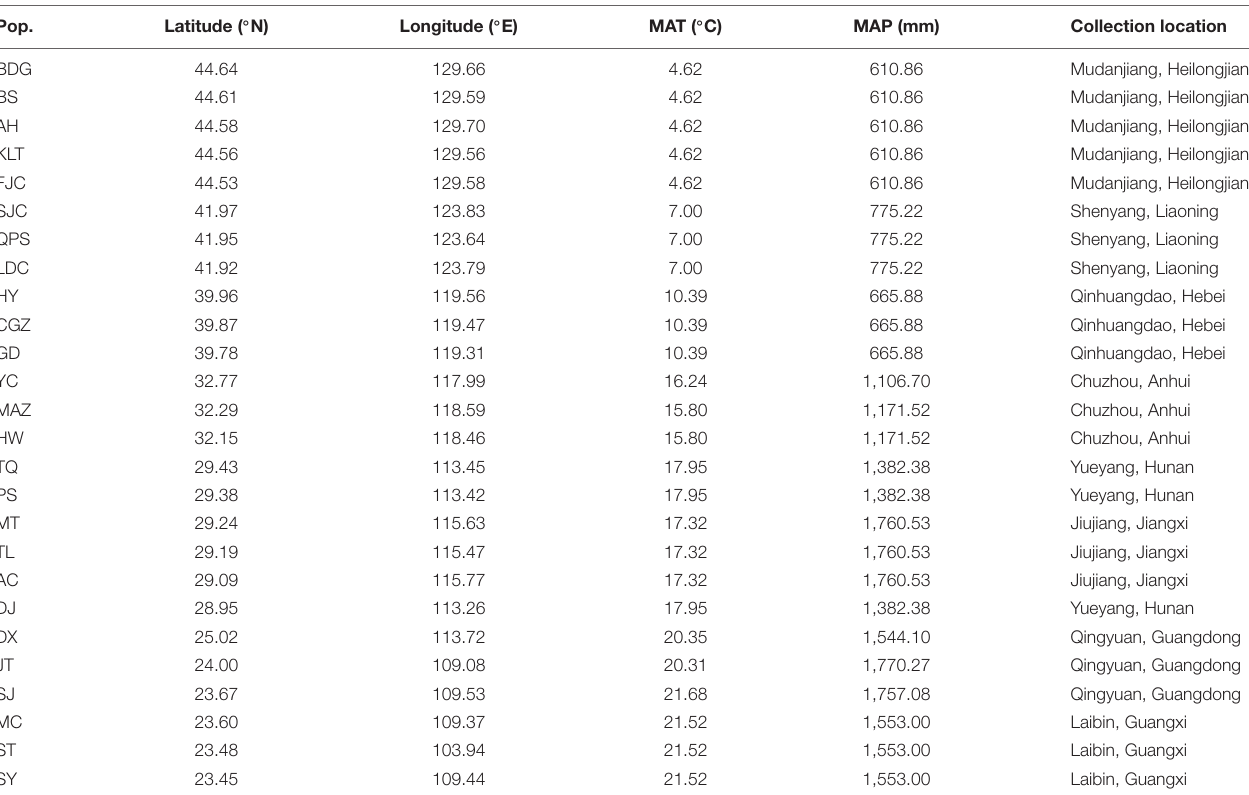
TABLE 1 | Geographic locations and home climate (mean annual temperature, MAT; mean annual precipitation, MAP) of 26 populations of Ambrosia artemisiifolia used in this study. Pop. Collection